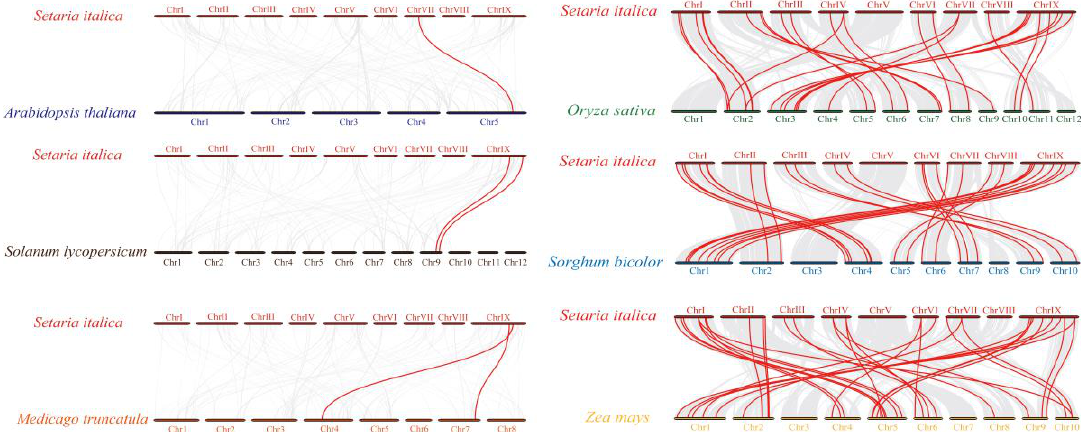
Figure 3. Homology of CCT genes between foxtail millet and six representative plant species. Gray lines in the background represent collinear blocks in the genomes of millet and the other plant species, and red lines highlight collinear CCT gene pairs.